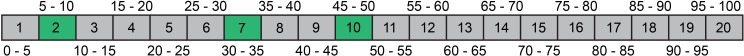
LOS path sections.Each LOS path was divided into 20 5-m sections and three sections were randomly selected for each LOS path. This figure shows the 20 sections and their locations along the LOS path. Sections highlighted in green represent the three randomly selected sections for which all vegetative obstructions were measured using the key in Table 1.